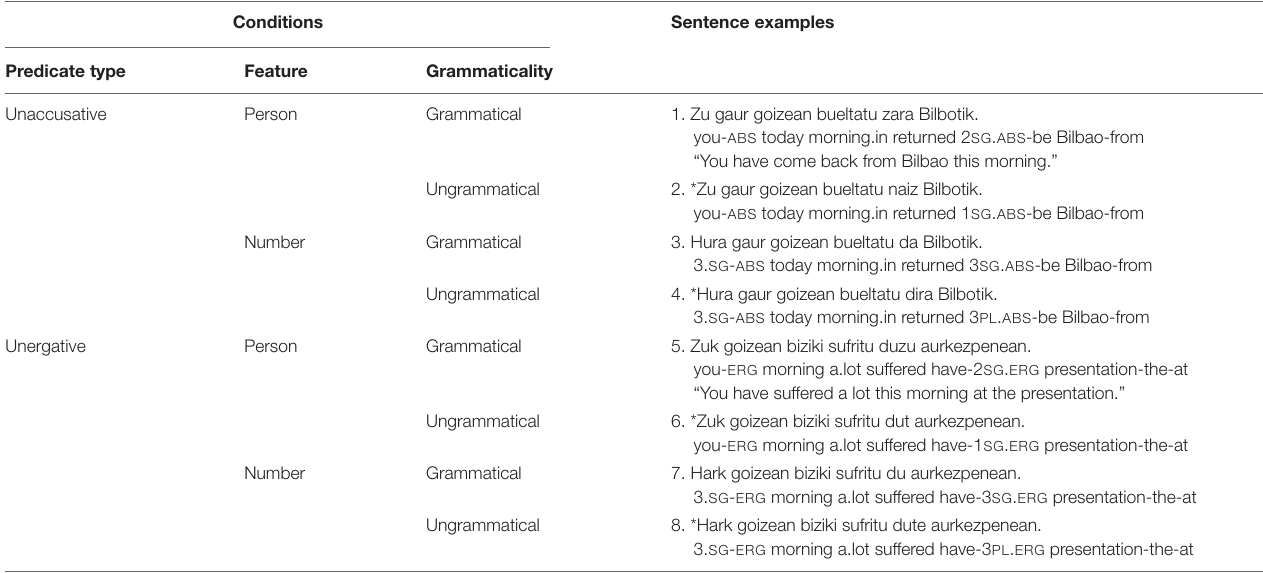
TABLE 2 | Experimental conditions with examples of experimental